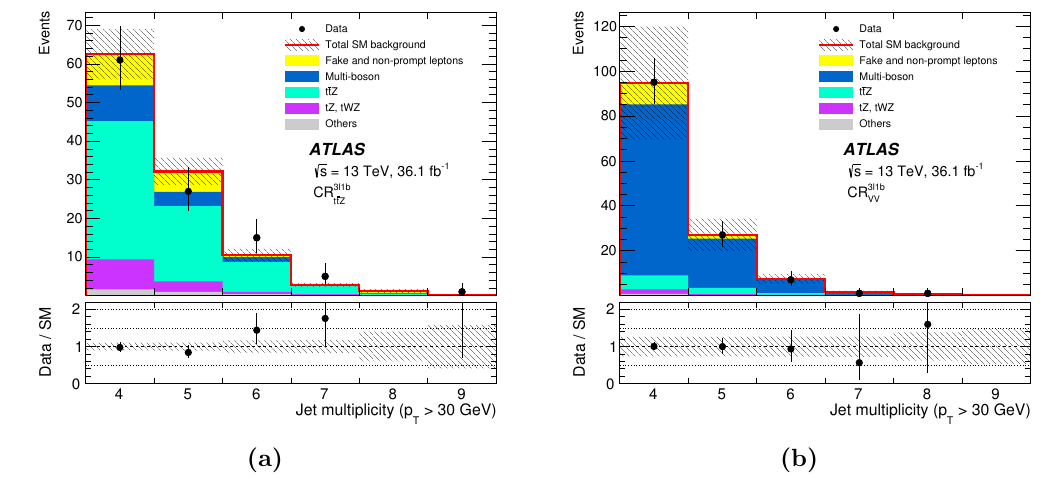
Figure 2. Jet multiplicity distributions in control regions (a) CR 3 ‘ 1 b ising the t (cid:22) tZ and multi-boson background processes via the simultaneous (cid:12)t described in section 5. The contributions from all SM backgrounds are shown as a histogram stack; the bands represent the total uncertainty in the background prediction. The \Others" category contains the contributions from t (cid:22) th , t (cid:22) tWW , t (cid:22) tt , t (cid:22) tt (cid:22) t , Wh , and Zh production. The last bin in each (cid:12)gure contains the over(cid:13)ow. The lower panels show the ratio of the observed data to the total SM background prediction, with bands representing the total uncertainty in the background